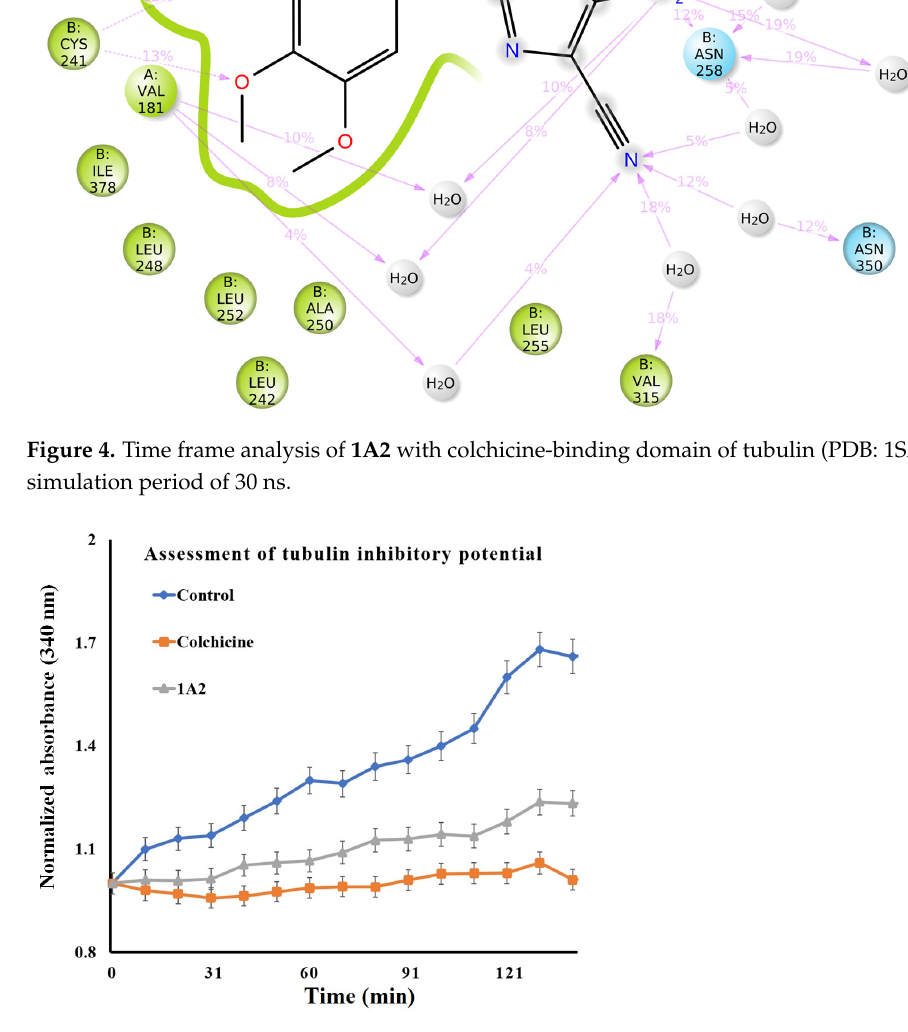
Figure 5. Graph suggesting the tubulin inhibitory potential of 1A2 compared with colchicine em- ployed as a positive control for tubulin assay. Table 2. In vitro antiproliferative activity (IC 50 in µM) of compound 1A2 against MCF-7, MD-MB- 231, HCT-116, and A549 cancer cell